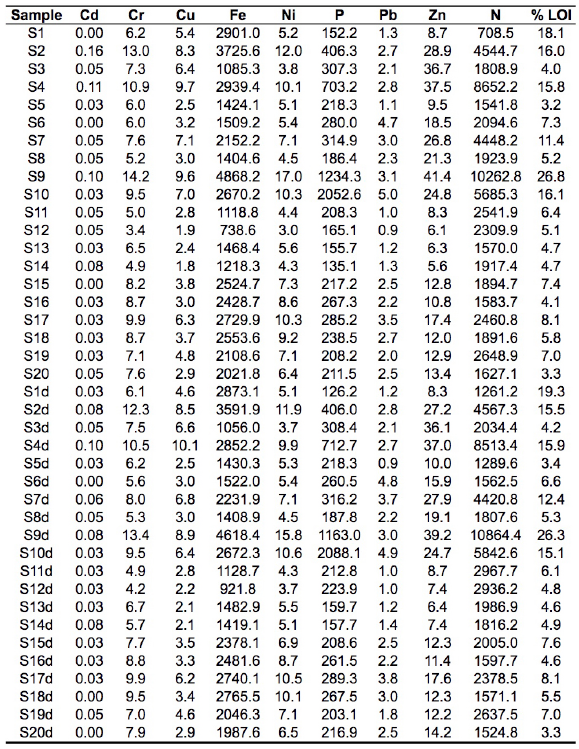
Table 2: The concentrations of metals, P and N in ug/g and LOI in % for the 20 original samples and the 20